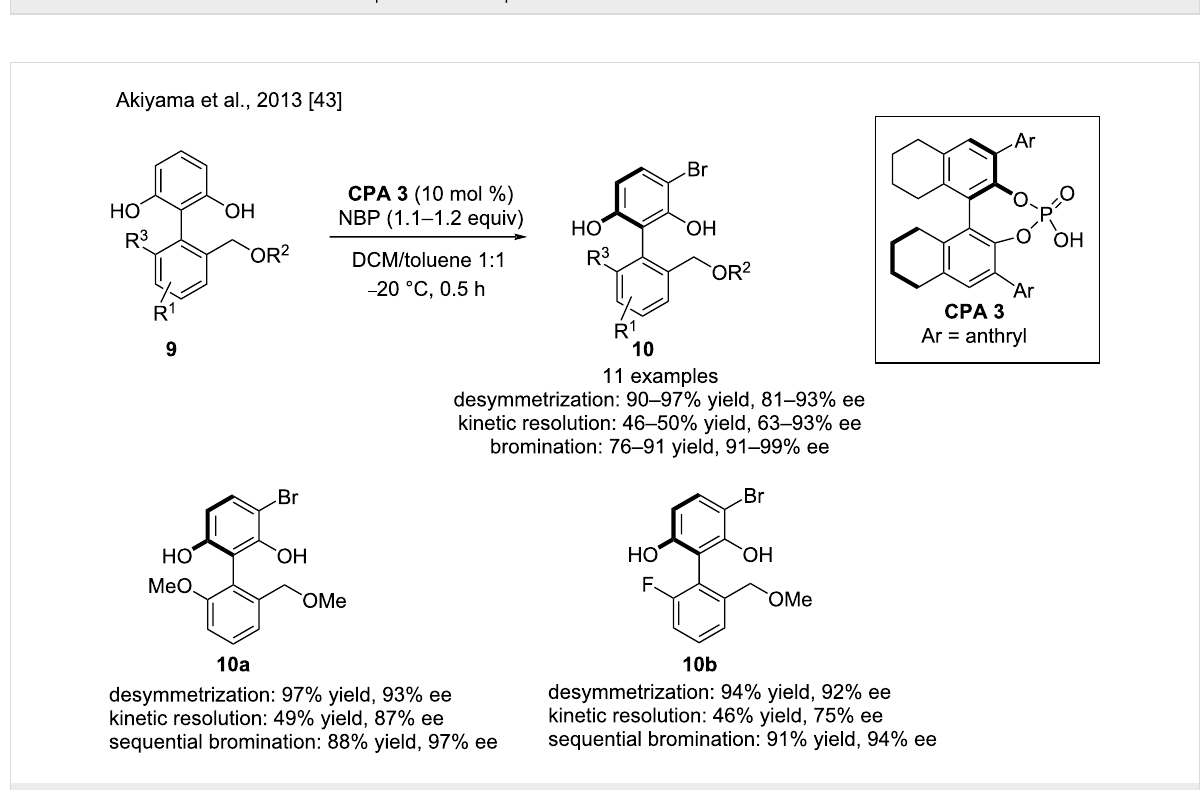
Scheme 4: Enantioselective synthesis of multisubstituted